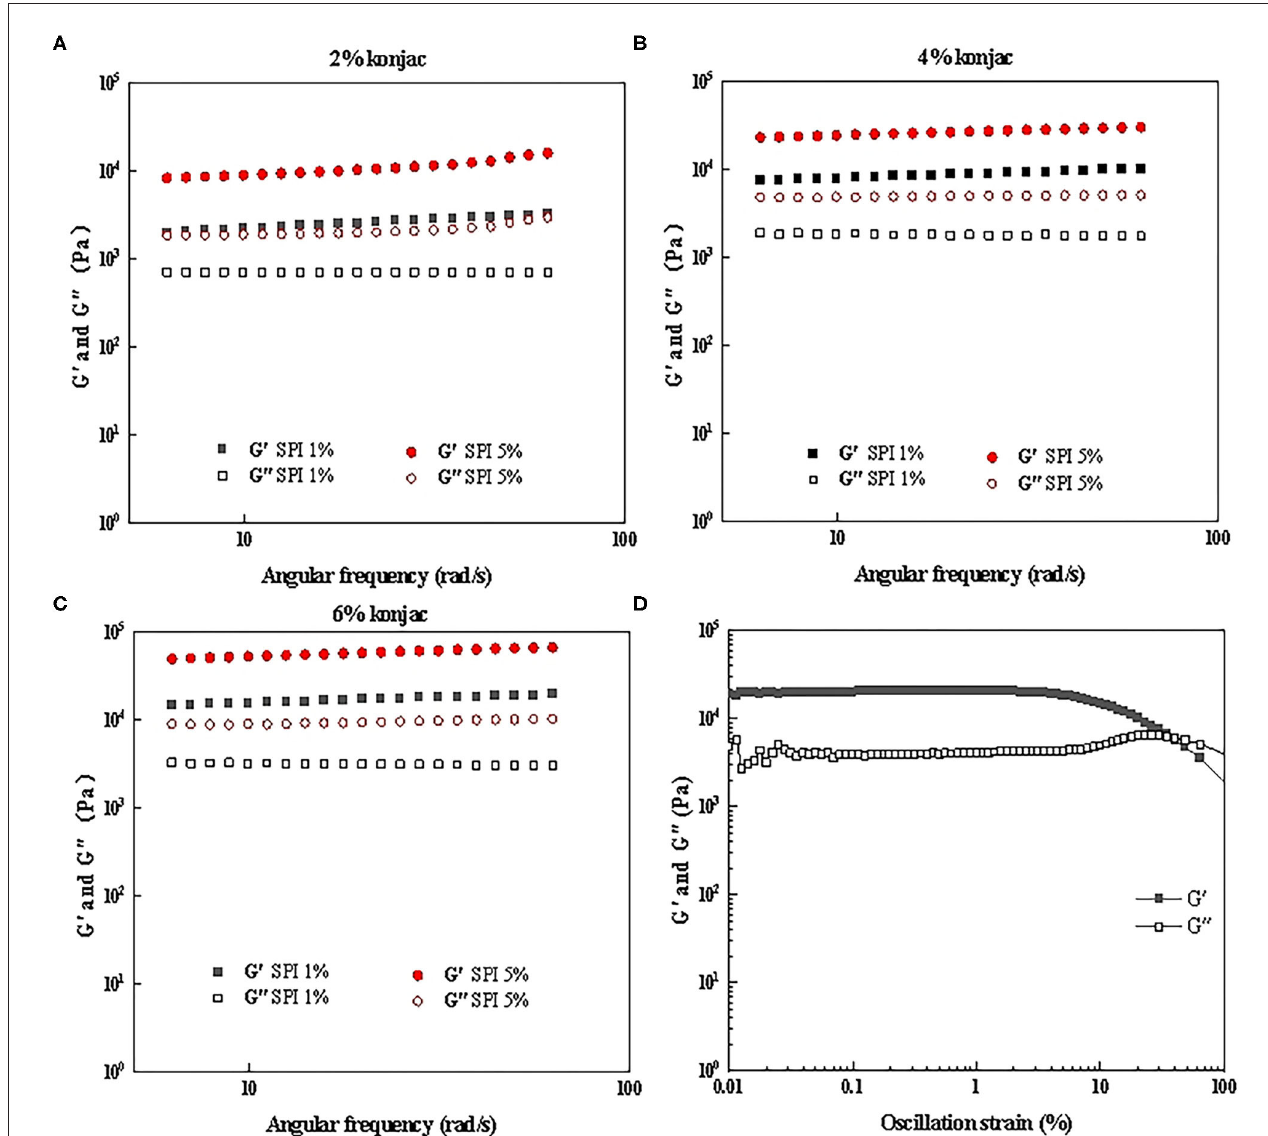
FIGURE 6 | The frequency scanning results of samples with different protein content and konjac content. (A) S1K1, S5K1; (B) S1K4, S5K4; (C) S1K6, S5K6; (D) Amplitude scanning results of